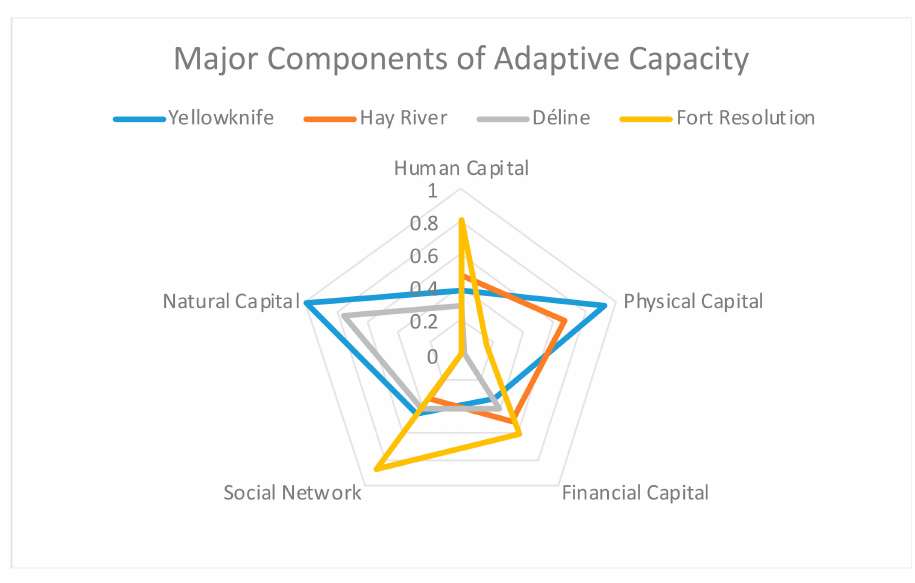
Figure 7. Each community’s ability to adapt to each of the individual capitals under adaptive capacity (human capital, physical capital, financial capital, social network, natural